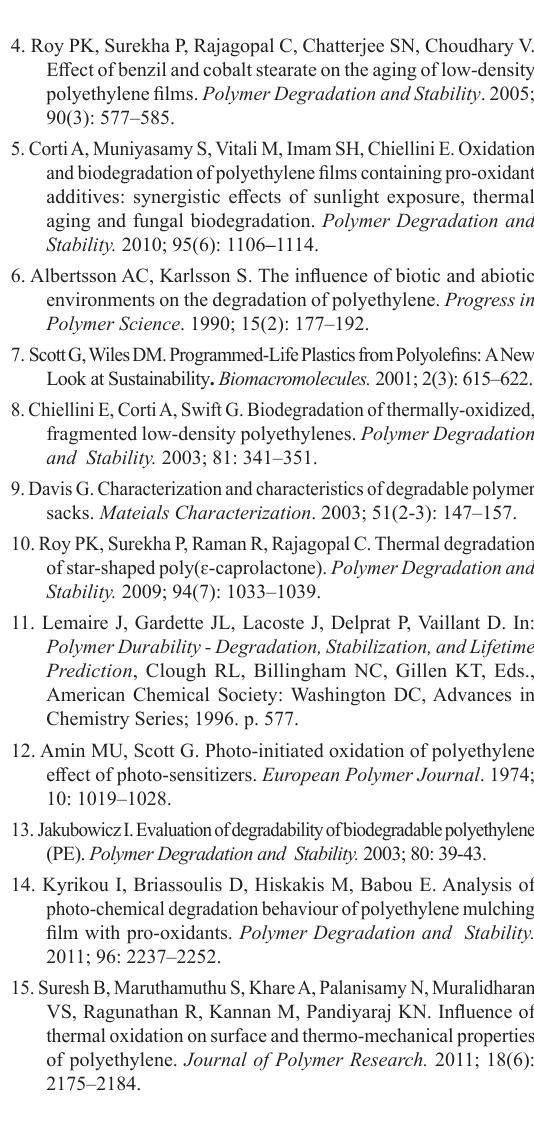
Figure 4: Dependence of the elongation at break of foils of initial irradiated HDPE and irradiated foils containing pro-oxidants at different exposure